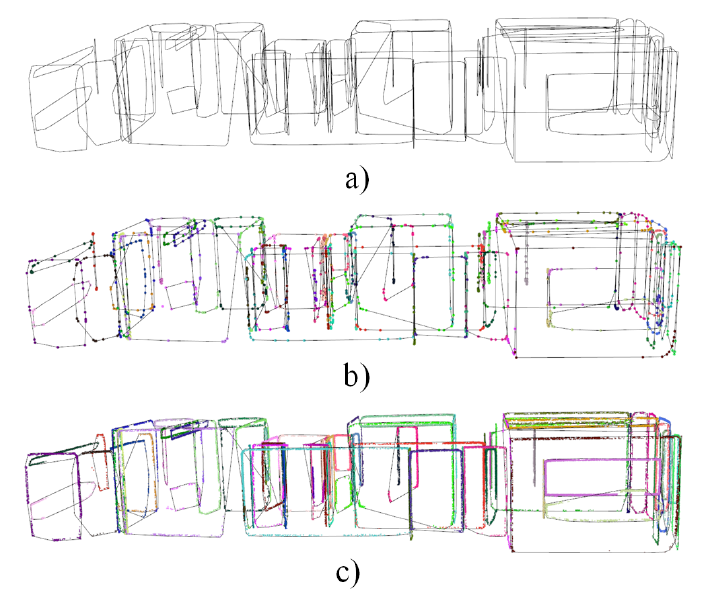
Figure 9. The process of boundary points extraction: ( a ) Convex hull, ( b ) key points on the convex polygon, ( c ) boundary